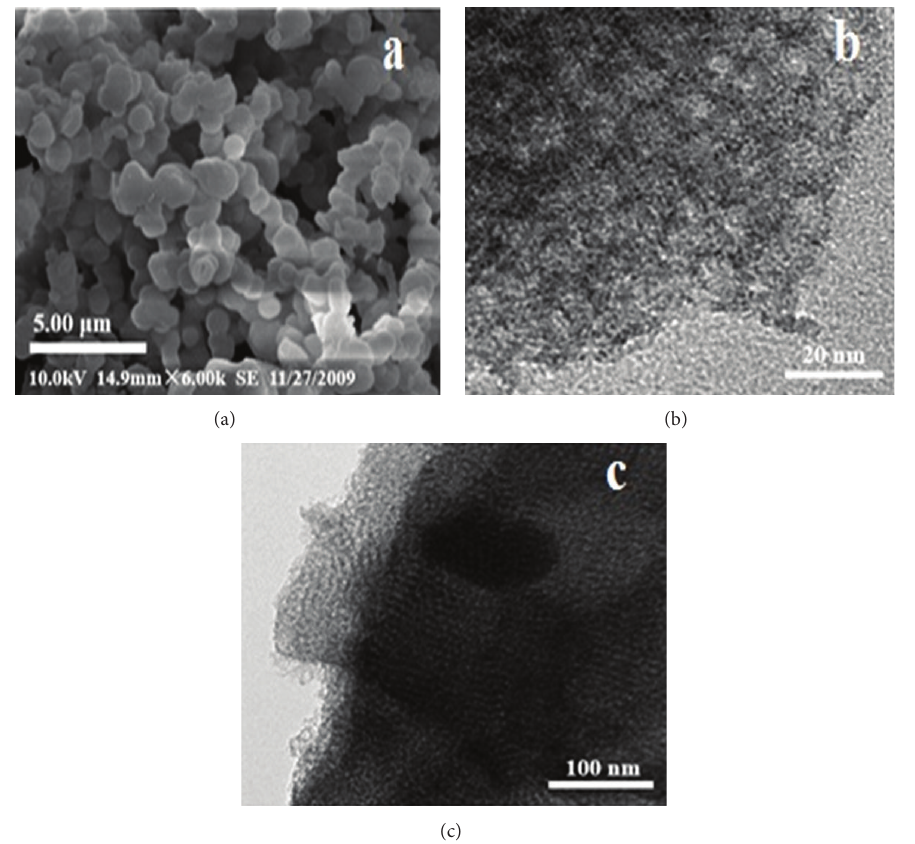
Figure 1: SEM (a) and TEM (b and c) images of the synthesis MFS-02.